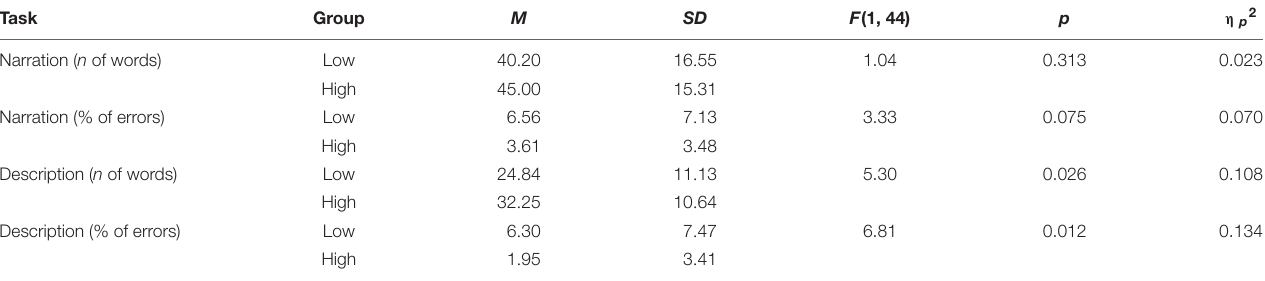
TABLE 3 | Descriptive statistics and results of the univariate tests comparing the two groups on the expressive writing tests.